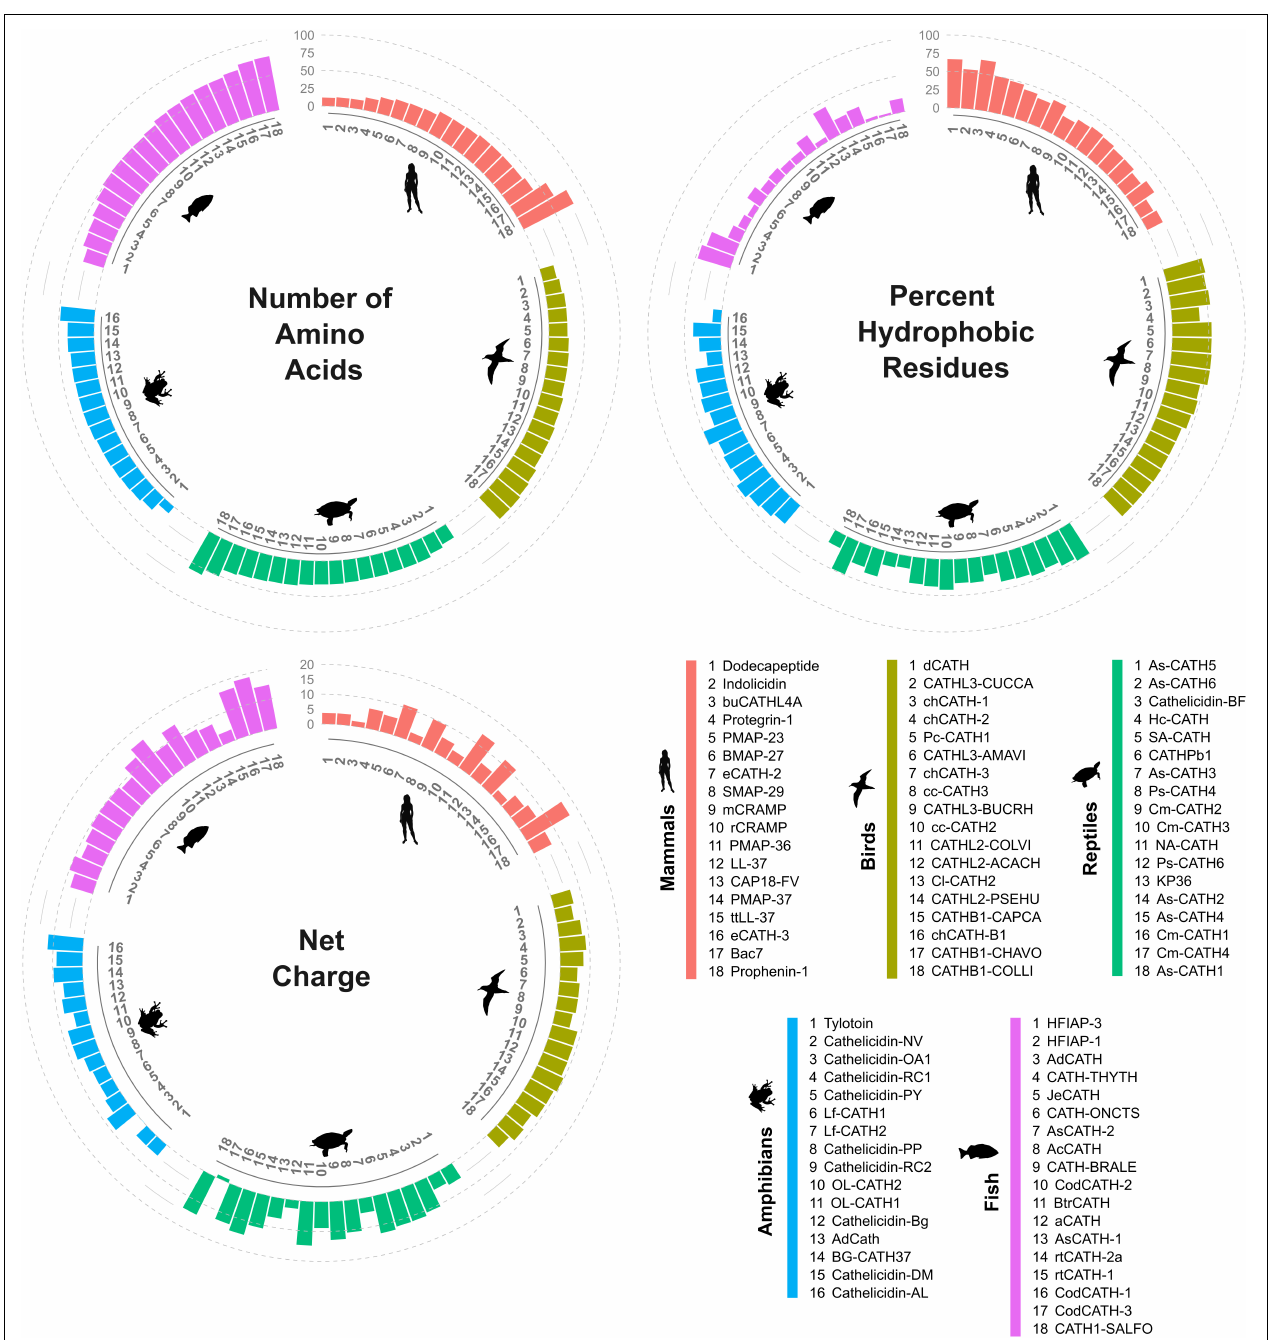
FIGURE 1 | Diversity of cathelicidin peptides among vertebrate groups. Circular bar plots show the distribution of length, charge and proportion of hydrophobic amino acids among representative vertebrate cathelicidin peptides (see Supplementary Table S1 ). The order of sequences in each group is sorted by peptide length. Physico-chemical properties were computed using the Peptides package v2.4.2 (Osorio et al., 2015) in R v4.0.0 (R Core Team, 2020). Net charge was predicted using the Bjellqvist’s pK scale implemented in the Peptides package. Animal silhouettes were created by: NASA (mammals; human), Juan Carlos Jerí (birds; shearwater), uncredited (reptiles; turtle), Will Booker (amphibians; tree frog) and Felix Vaux (fish), and downloaded from http://phylopic.org/.